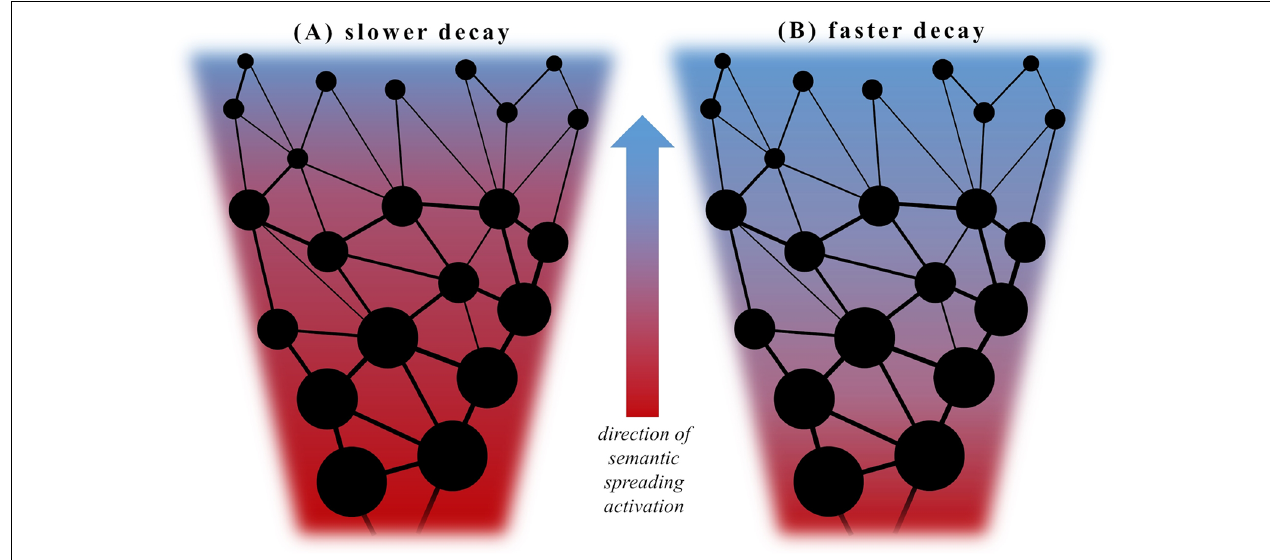
FIGURE 1 | Decay of semantic spreading activation. Panels (A) and (B) show each a schematized segment of a conceptual network (or semantic category in terms of VF task performance) with densely interconnected stored items as “nodes”. Thick (high relatedness) or thin (lower relatedness) lines indicate the degree of semantic association between items. Larger points represent items with a high frequency of occurrence whereas smaller points infrequent ones. Semantic spreading activation is depicted as a centripetal flow from highly connected and frequent items produced early during VF tasks to more sparsely inter-connected and infrequent items in the periphery. The direction (or decay in time) of semantic spreading activation is indicated by the color shift from red to blue. In this view, relatively infrequent items require a stronger degree of (or more sustained) semantic activation for retrieval than more frequent ones. The retrieval of such low frequency items would therefore be facilitated by a slow decay (A) and impeded in case of faster decaying activation spread (B) . In the latter case, more highly frequent items would be accessed, possibly with a higher rate of repetition errors.